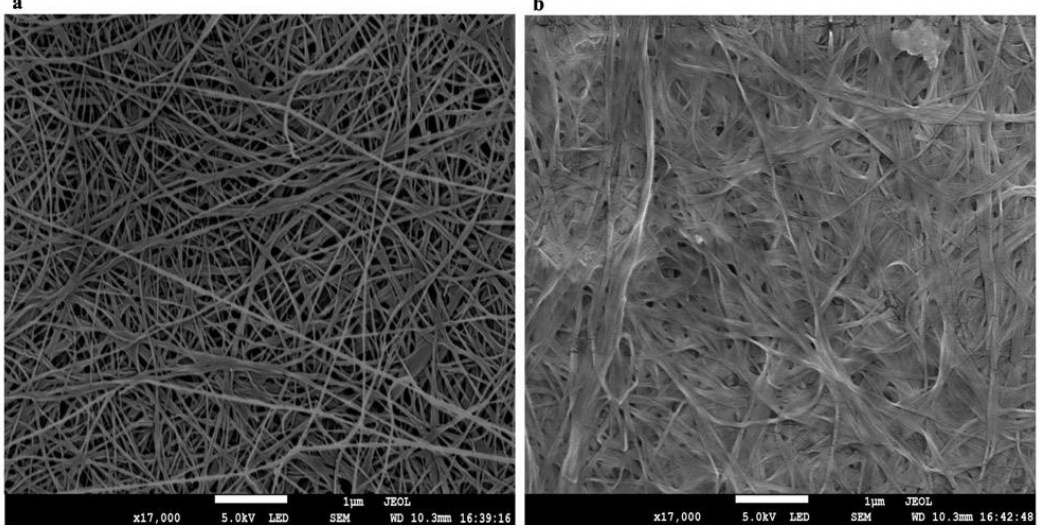
Figure 5. SEM images of BC ( a ) and BC/PUL ( b ) films.